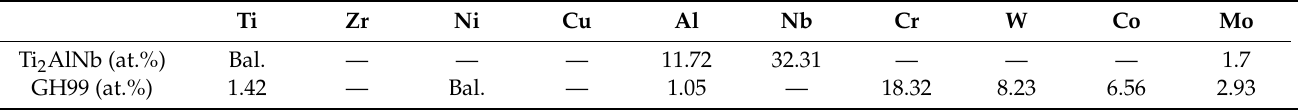
Table 1. Chemical composition of the parent metals and filler